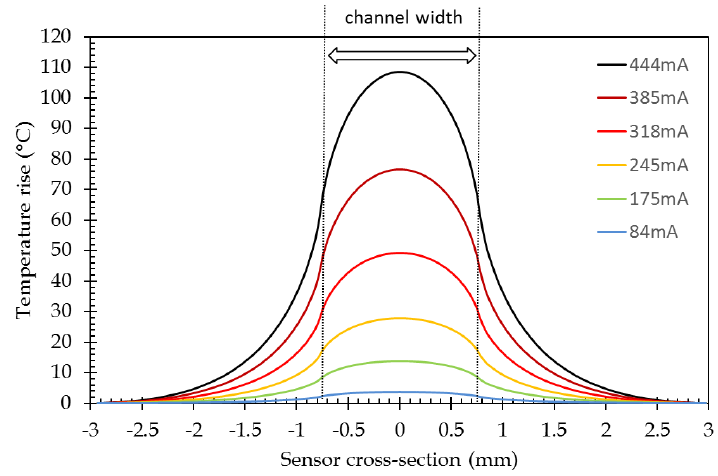
Figure 7. Rise of temperature-induced by the current injection (sensor cross-section: 0 corresponds to the channel center).